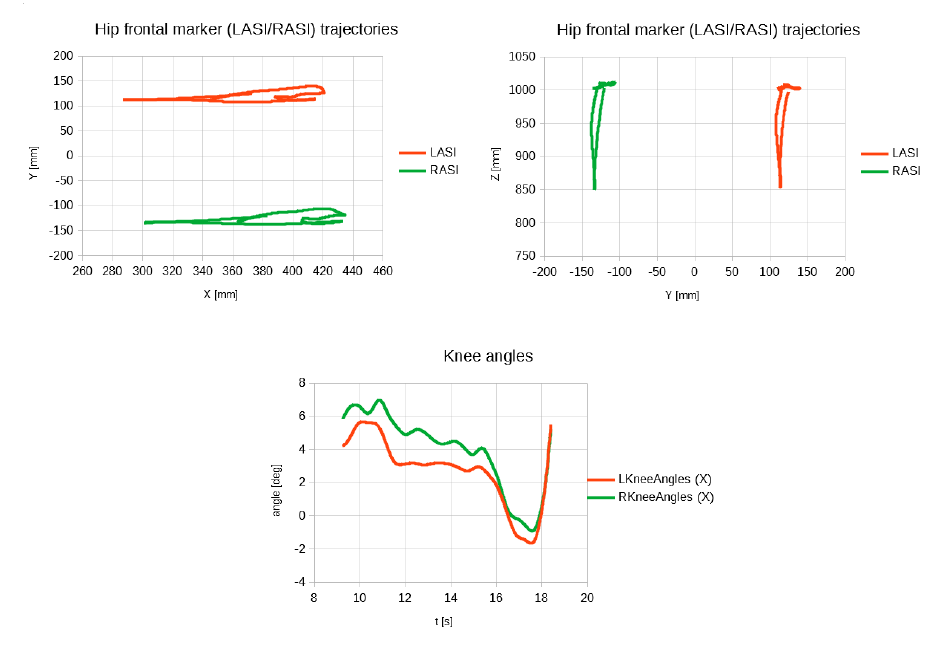
Figure 5. Trajectories for lower body parts for the first